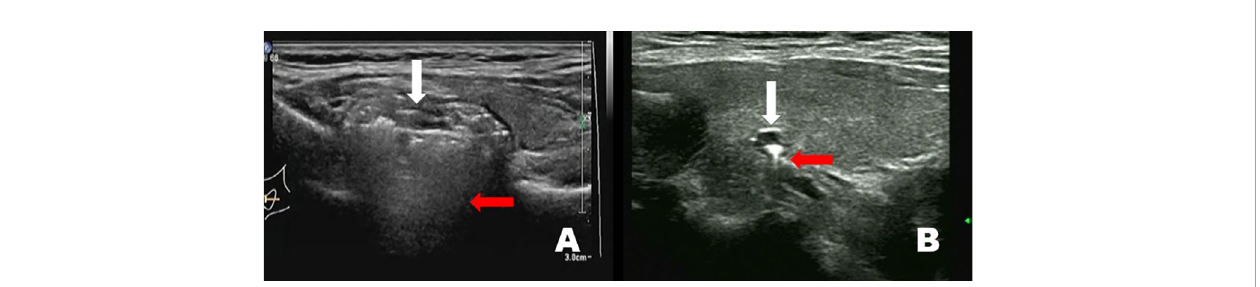
FIGURE 6 Some air-containing nodular diverticula are full of gas-like hyperechoicity internally and have a typical “ V ” tail sign (A) , image from a 35 year-old woman). Some have a hyperechoic linear appearance and sometimes have a typical “ T ” tail sign (B) , image from a 63-year-old woman).